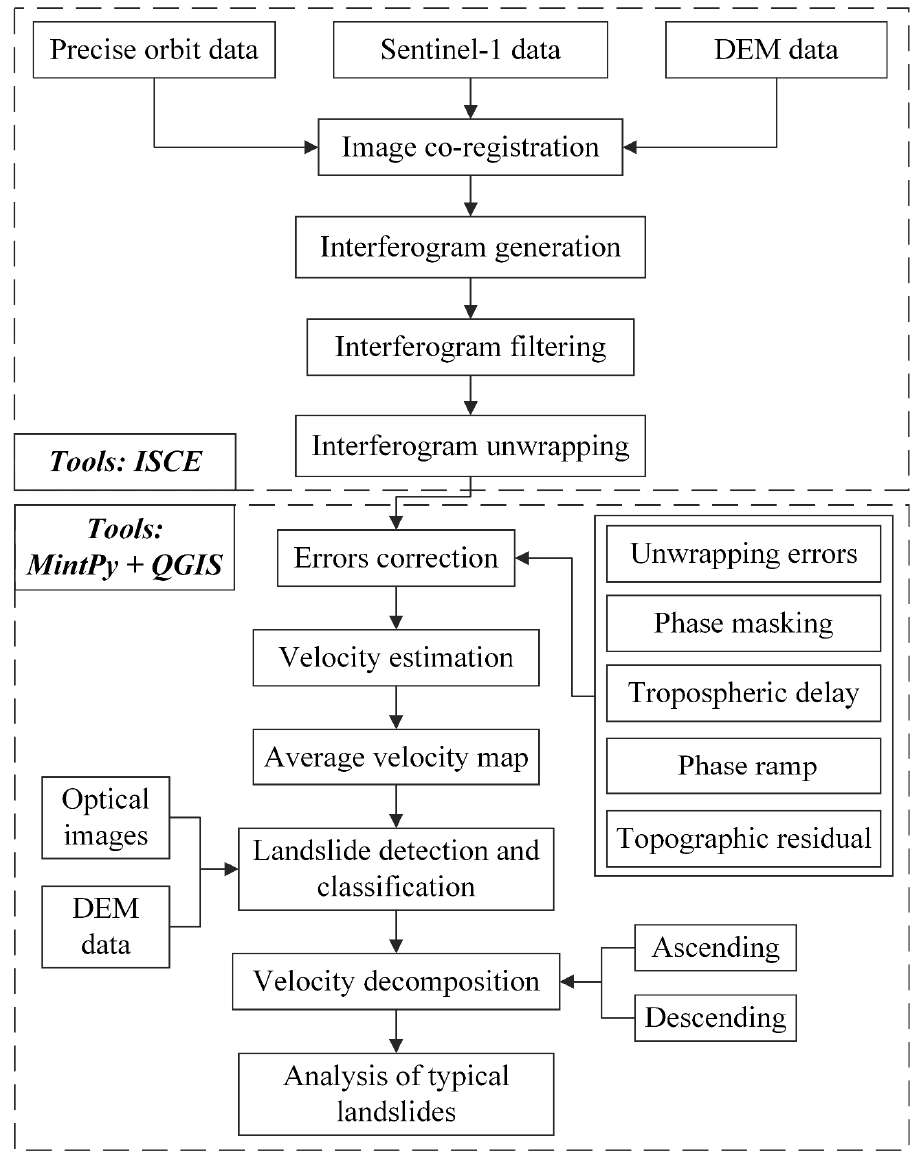
Figure 3. Workflow of this study.